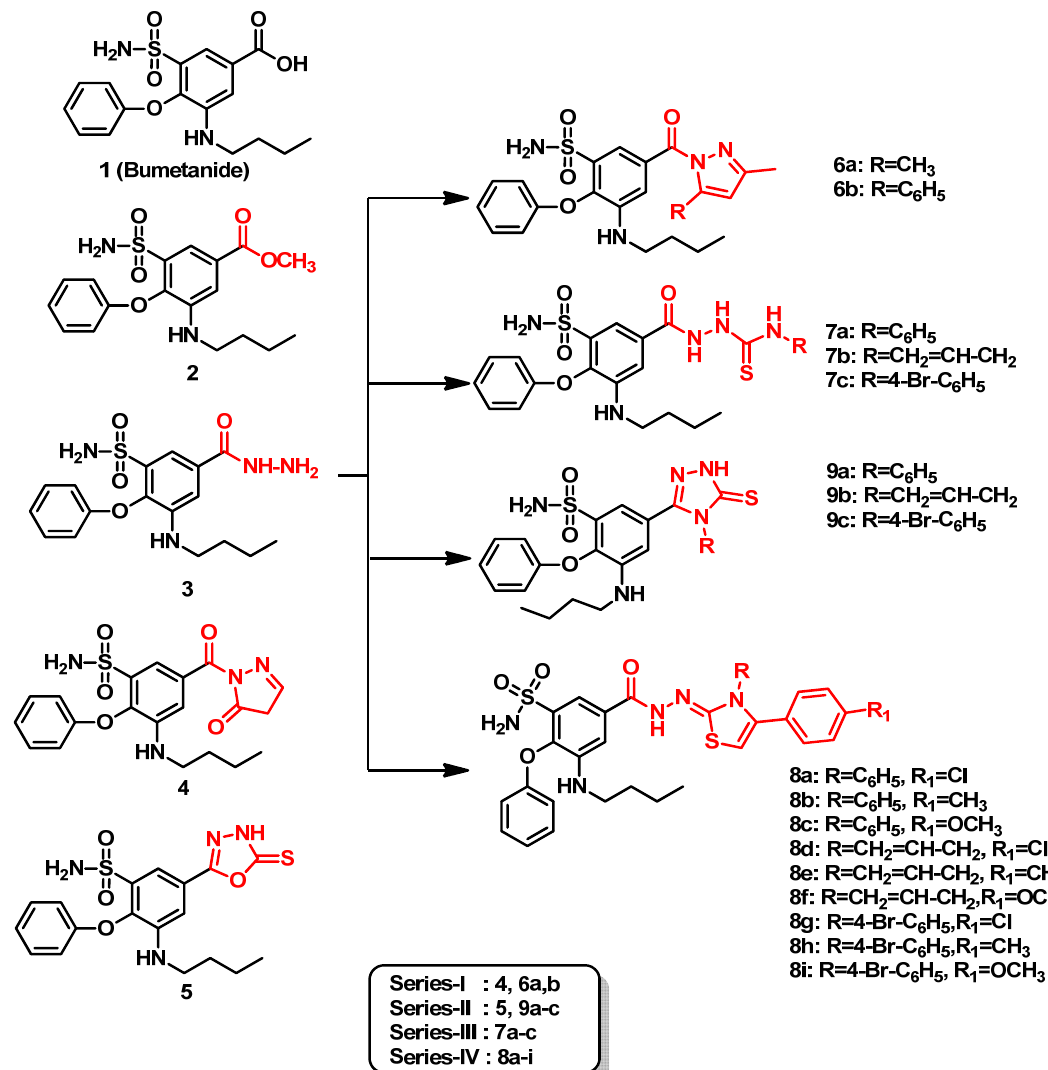
Figure 2. The chemical structures of the proposed benzenesulfonamide-based compounds as promising h CA-IX inhibitors. They are classified into four Series ( I – IV ) based on tail part homology, bioisosteric homology, and spatial size